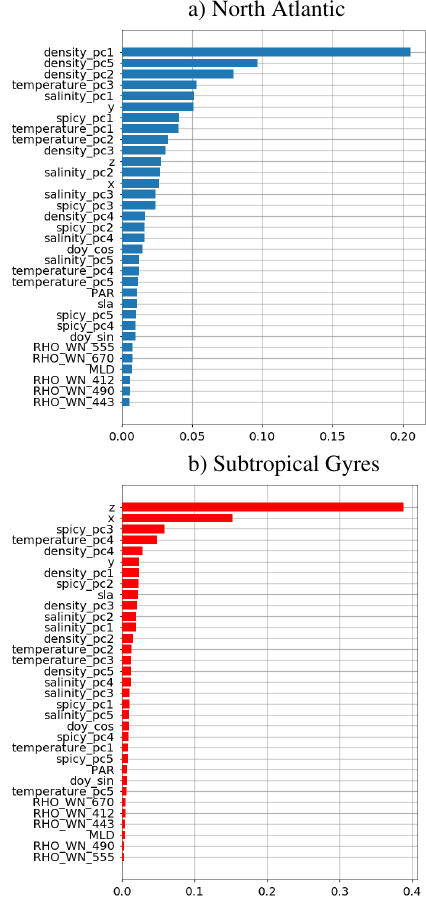
Figure 5. The feature importance of the Random Forest algorithm for the test dataset for the a) North Atlantic and b) Subtropical Gyres. This plot explains the importance of each feature as learned from the